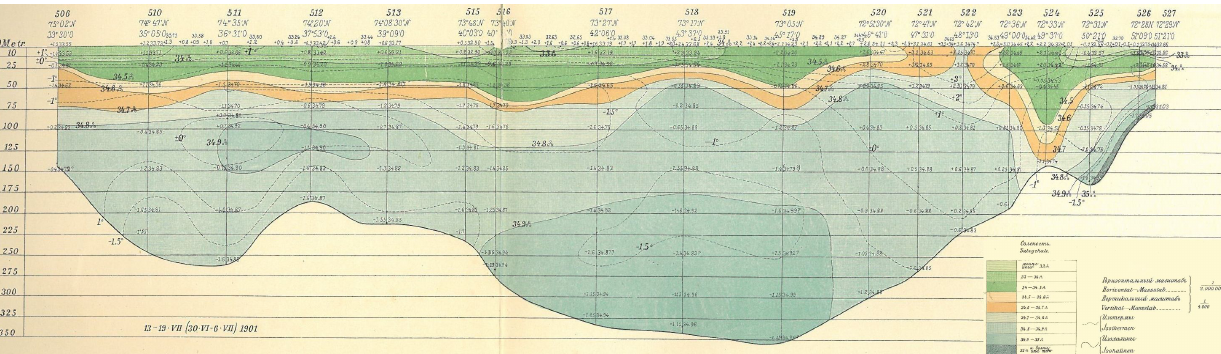
Fig. 15. Temperature and salinity section from 75 ◦ 02 0 N, 33 ◦ 30 0 E (Central Bank) to 72 ◦ 29 0 N, 51 ◦ 21 0 E (Novaya Zemlya) showing cold and brine enriched saline water on the shallow area west of Novaya Zemlya in 1901. From Knipowisch (1905).